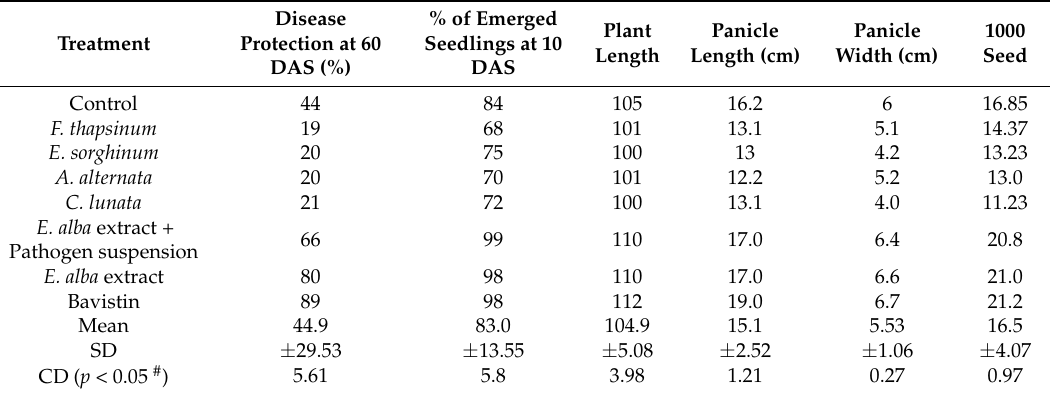
Table 4. Influence of purified E. alba methanol extract on sorghum pathogens and growth parameters under field conditions. % of Emerged Disease Treatment Protection at 60 Seedlings at 10 DAS (%) DAS